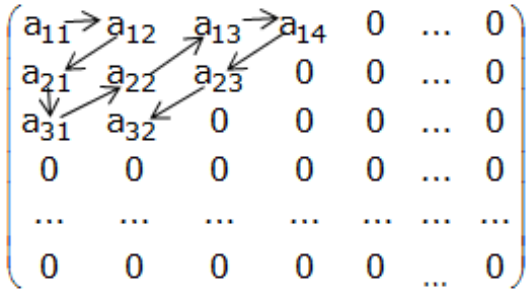
Figure 6. Zigzag fashion to retain the first nine coefficients.